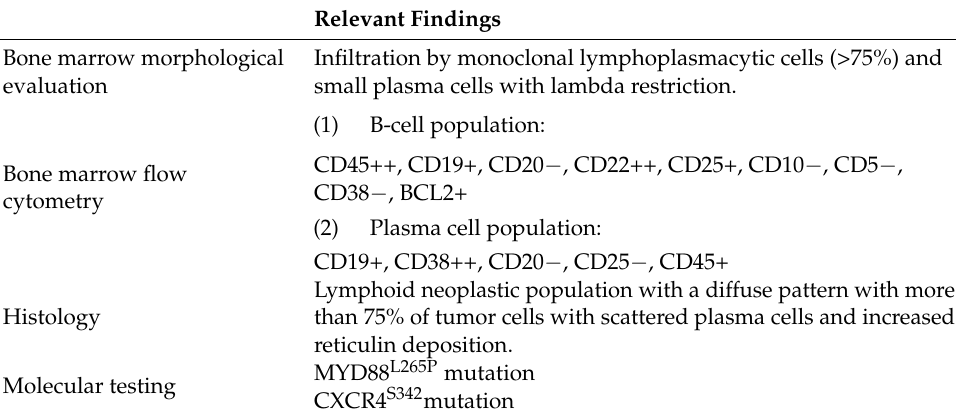
Table 1. Analytical characteristics of the patient’s disease. BM evaluation, flow cytometry, histology and molecular